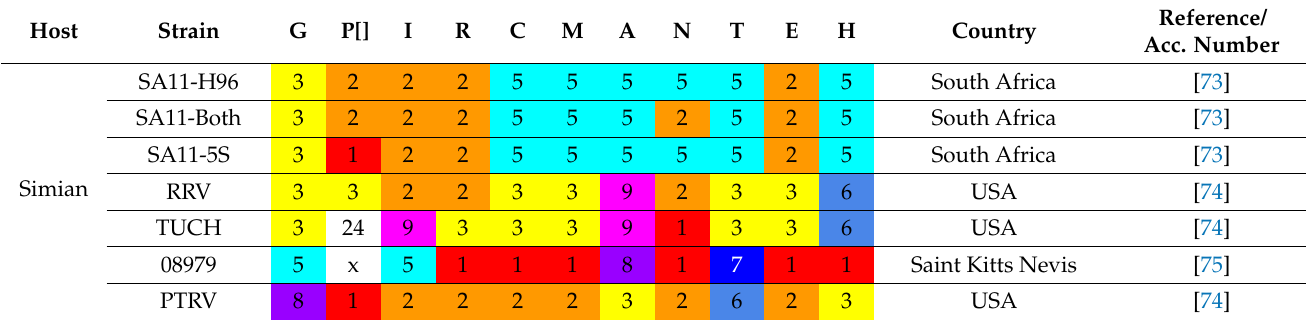
Table A9. Simian constellations.